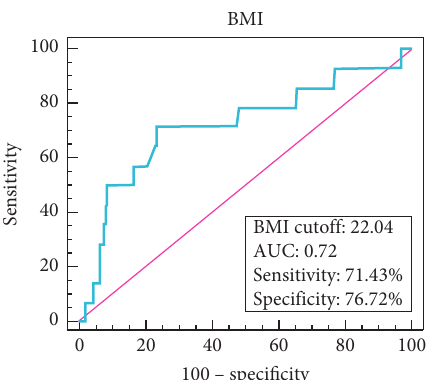
Figure 3: The AUC of BMI for failure in the dTRA group. The AUC was 0.72 (95%CI, 0.668 to 0.769). The cut-off baseline value for BMI was set to 22.04 with specificity of 76.72% and sensitivity of 71.43%, respectively.